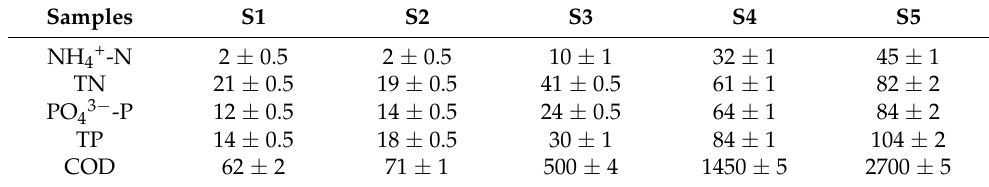
Table 2. Changes in several basic parameters in the liquid phase after pretreatment (unit: mg/L).